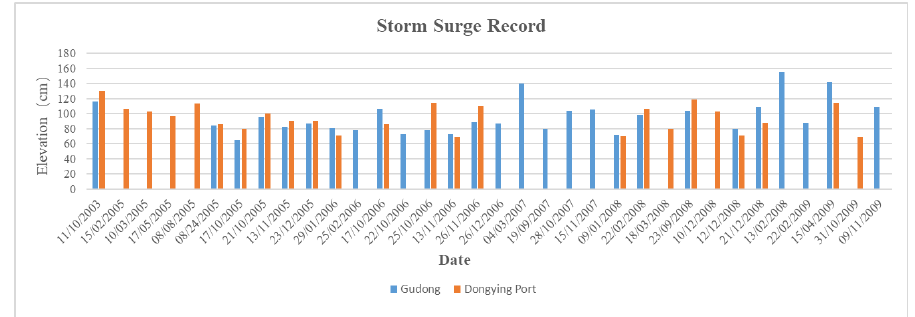
Figure 18. Storm surge records for the Gudong tide gauge station and Dongying port. As the distance is very close, and the law of tidal changes is consistent, the storm surge interval value is taken from the records of the above two stations.